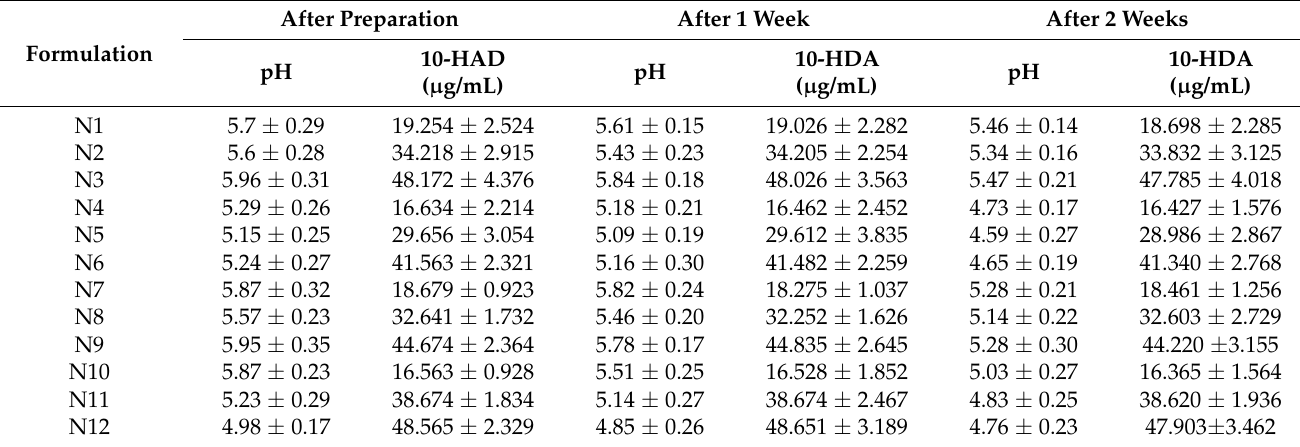
Table 7. The results of the stability of the in situ gel formulations evaluated by pH and the amount of 10-HDA in samples after two weeks. Data represent mean standard deviation (SD), n = 3.